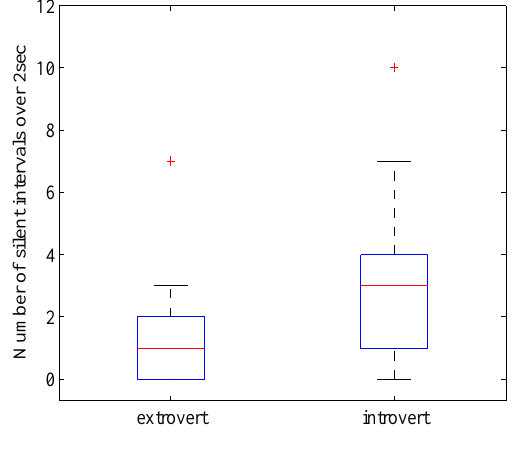
Fig. 3. Number of silent intervals in an extended dura- tion(long silence).(Source: findings from the preliminary experiments for this study)